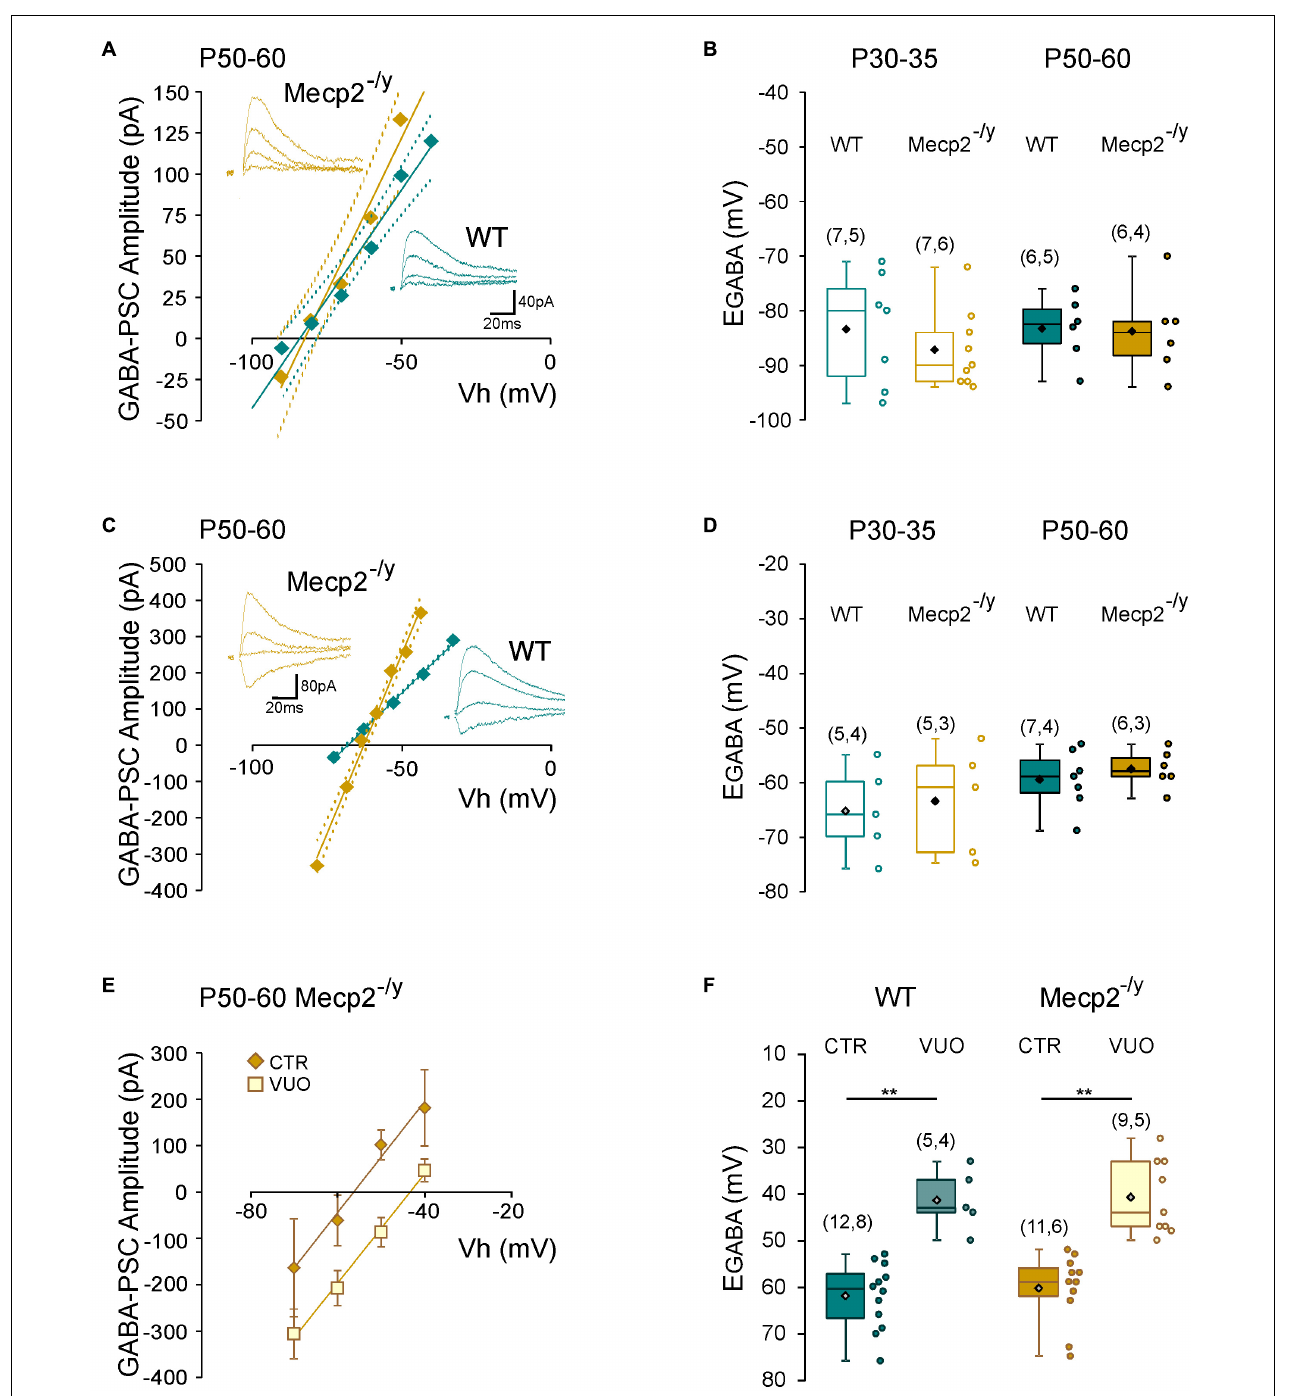
FIGURE 5 | Chloride homeostasis onto wild-type and Mecp2 - / y CA3 hippocampal pyramidal neurons. Current–voltage relationships (solid lines) and confidence interval (95%, dotted lines) (A,C) and box plots (B,D) of the reversal potential of evoked GABAergic synaptic currents (E GABA ) in WT and Mecp2 - / y CA3 pyramidal neurons. (A,B) Perforated gramicidin patch-clamp recordings. (C,D) Whole cell patch-clamp recordings. Insets: examples of GABAergic synaptic-currents evoked onto a P50–60 WT and Mecp2 - / y CA3 pyramidal neuron. (E) Current–voltage relationships of evoked GABAergic synaptic currents in P50–60 Mecp2 - / y CA3 pyramidal neurons and (F) E GABA in WT and Mecp2 - / y CA3 pyramidal neurons in control condition (Ctr) and in the presence of VU0463271 (VUO,10 µ M). ** P < 0.01, two-tailed Mann–Whitney U test.